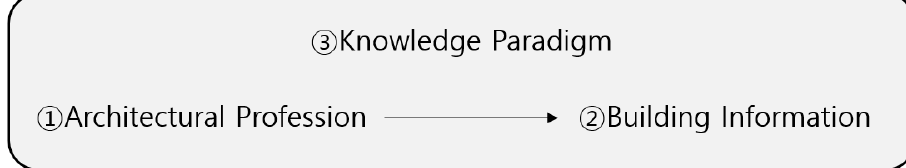
Figure 1. The correlation of the architectural profession, building information and the knowledge paradigm.